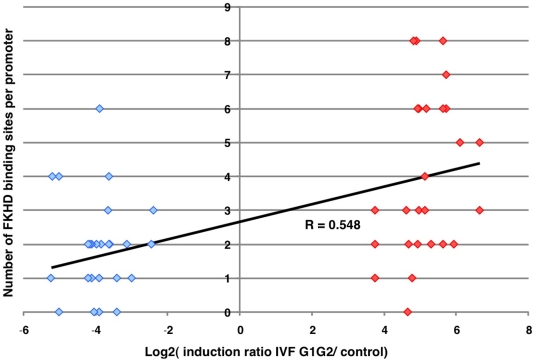
Correlation of representation of the FKHD factors in the promoters of genes highly induced or repressed in the IVF samples.By Student t-test analysis, the FKHD binding site was shown to be strikingly overrepresented in induced genes compared to repressed genes. The graph represents promoters of repressed genes on the left side, and of induced genes on the right side. The ordinate corresponds to the number of putative FKHD binding sites found in the promoters using Genomatix™, while the abscissa classifies the promoters according to the Log2 of the induction ratio between the G1/G2 culture conditions versus controls (r = 0.55, P<0.0001, t-test).